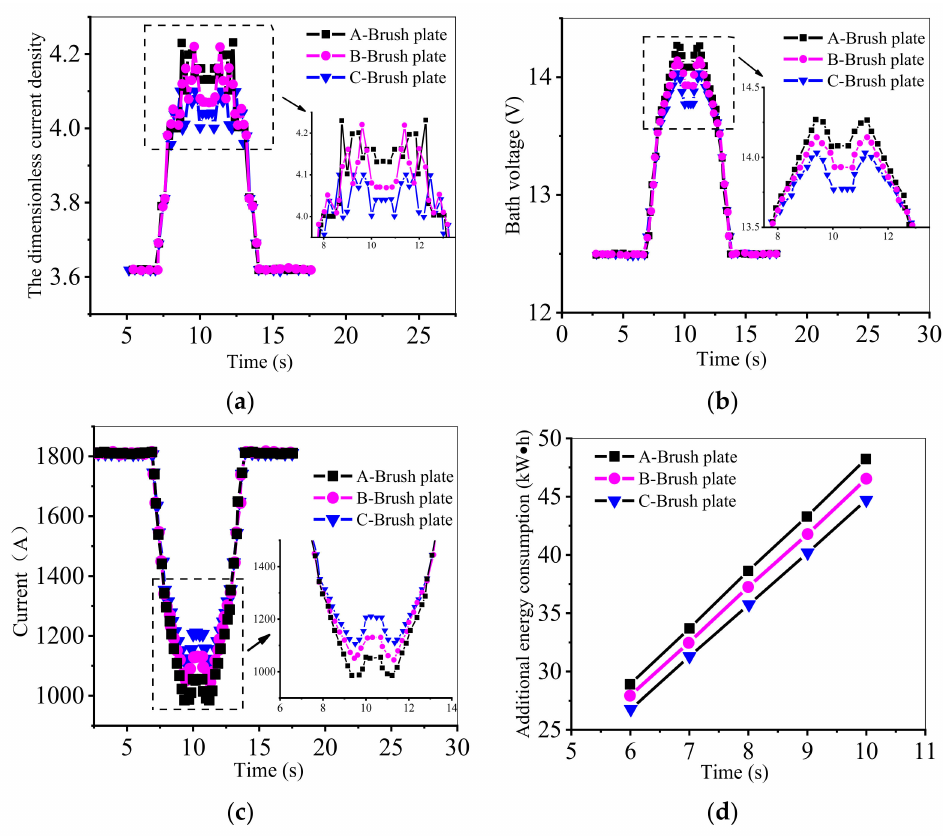
Figure 13. The variation of parameters with time. ( a ) The dimensionless current density; ( b ) Bath voltage; ( c ) Current; ( d ) Additional energy